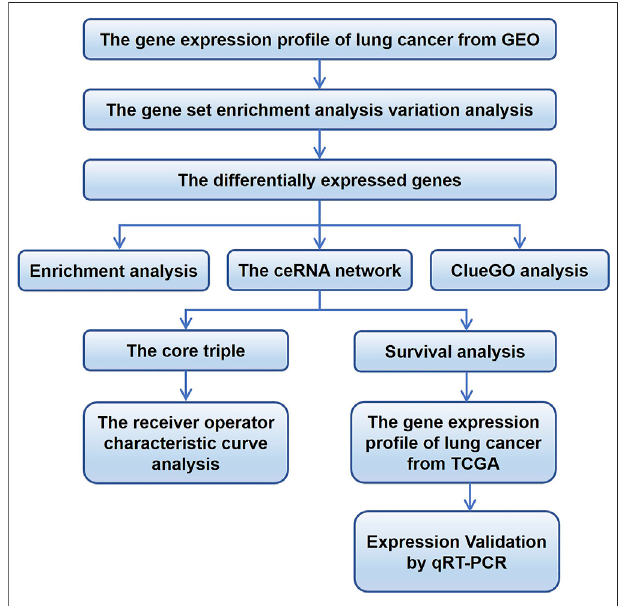
FIGURE 1 | Flowchart of the study. ceRNA, competing endogenous RNA; GEO, Gene Expression Omnibus; TCGA, The Cancer Genome